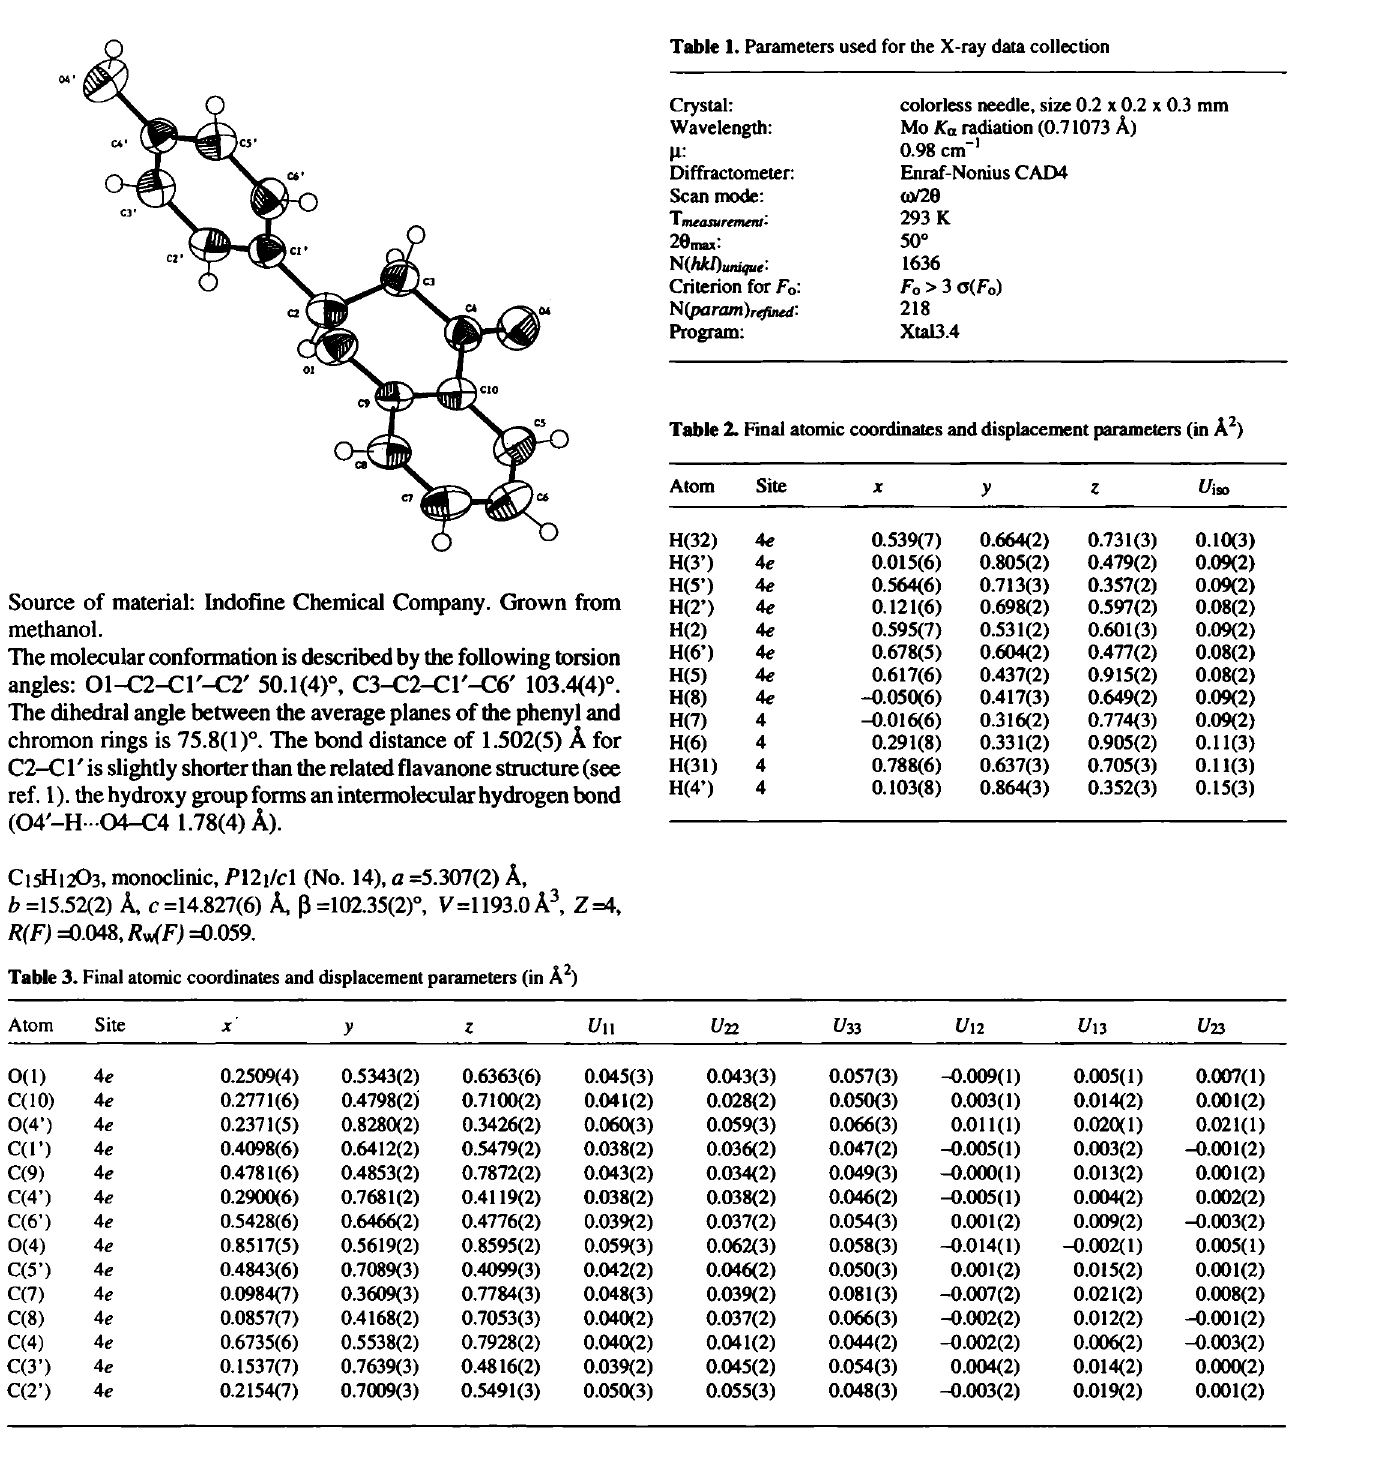
Table 1. Parameters used for the X-ray data collection